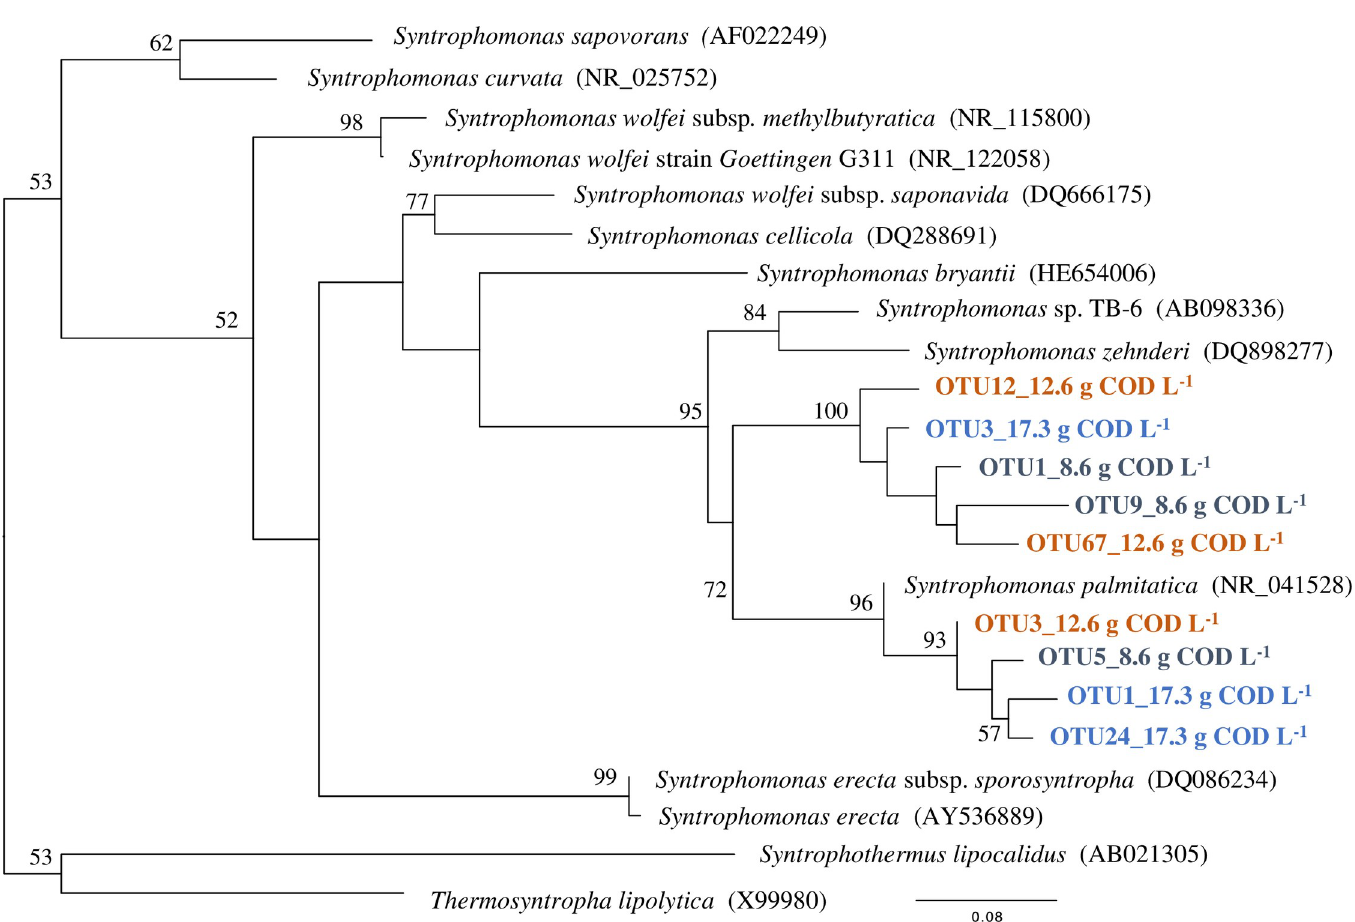
Fig 7. Phylogenetic tree based on 16S rRNA gene representing the top 3 abundant sequences in the taxon classified as Syntrophomonas . The significance of each branch is indicated at the nodes by bootstrap values (%) based on 100 replications. Only values greater than 50% are shown. The numbers following the scum loading concentration indicate the size of